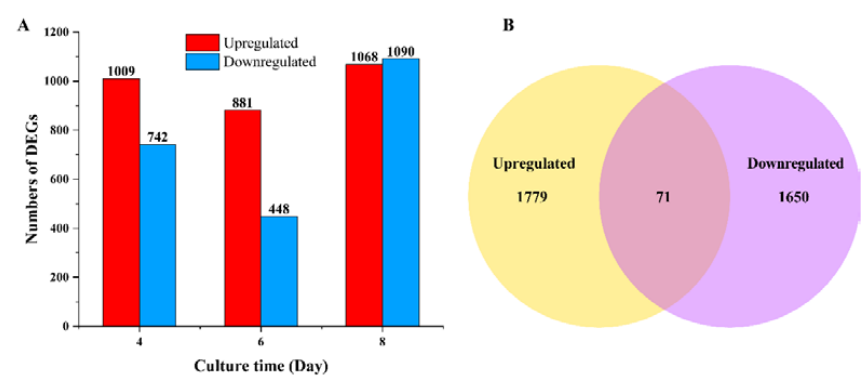
Figure 2. Differentially expressed genes (DEGs) between glucose and xylose as the carbon source. ( A ) The number of DEGs on days 4, 6, and 8. ( B ) Venn diagram of all DEGs for the three days.